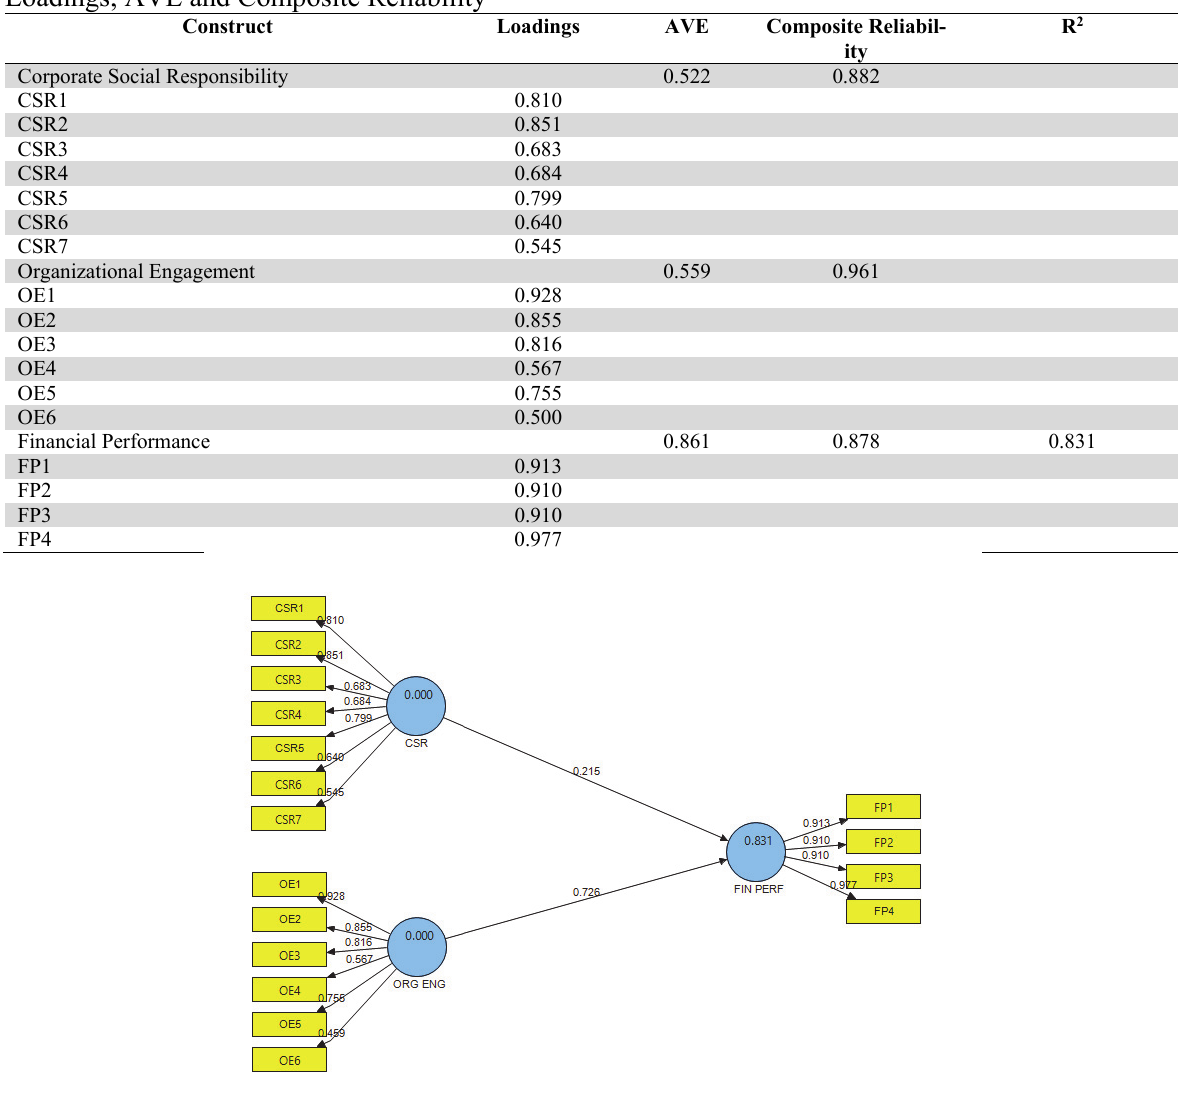
Fig. 1. Measurement